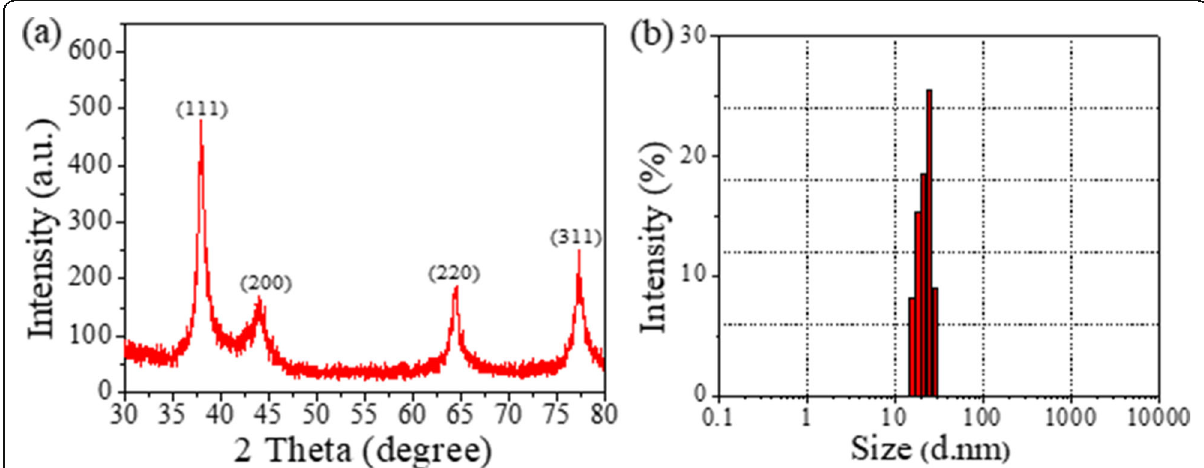
Fig. 4 ( a ) XRD pattern of CuO NPs and ( b ) DLS pattern of CuO